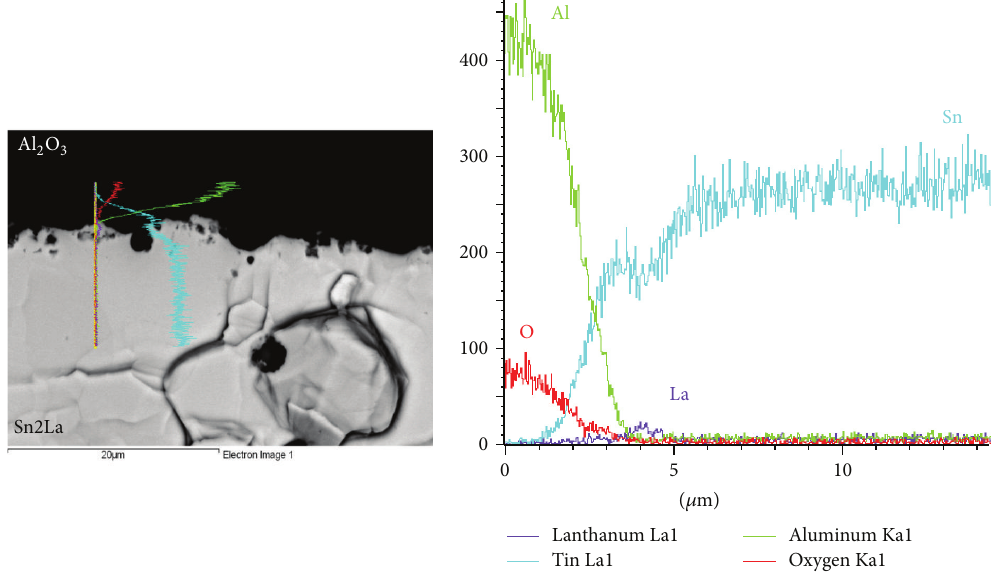
Figure 17: Concentration profiles of Al, Sn, La, and O 2 on Al 2 O 3 /Sn2La solder boundary.